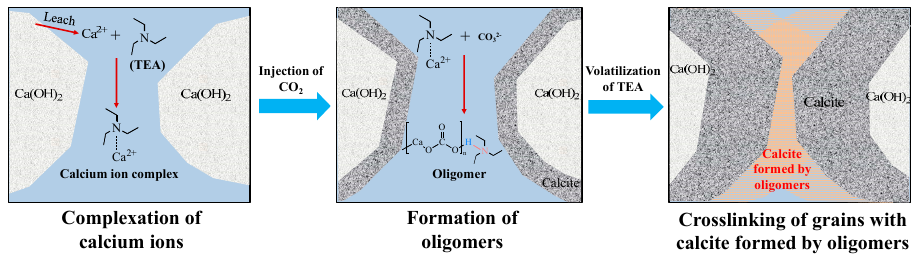
Figure 4. Mechanism of microstructure formation of CAM with TEA.